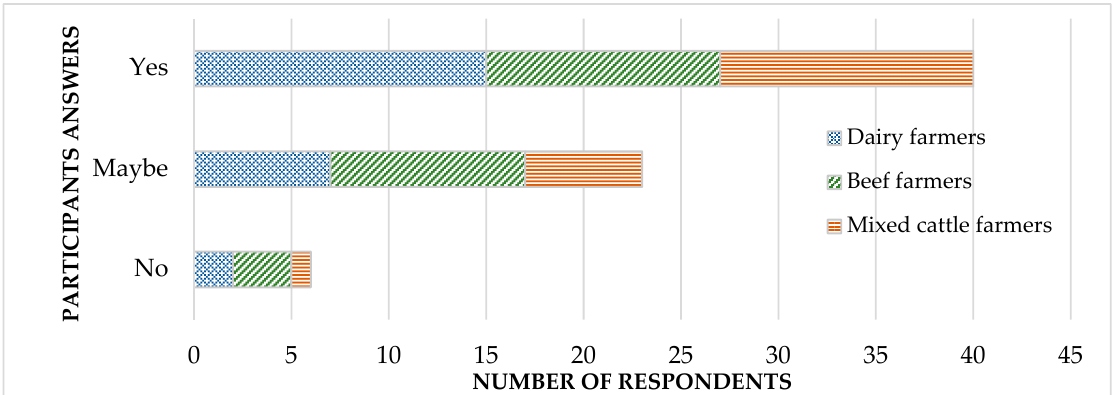
Figure 4. Survey responses willingness to partake in a co-operative scheme.